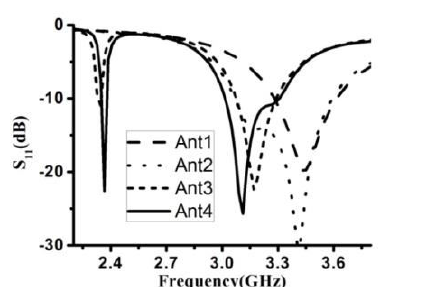
Figure 6: Return loss characteristics of the proposed